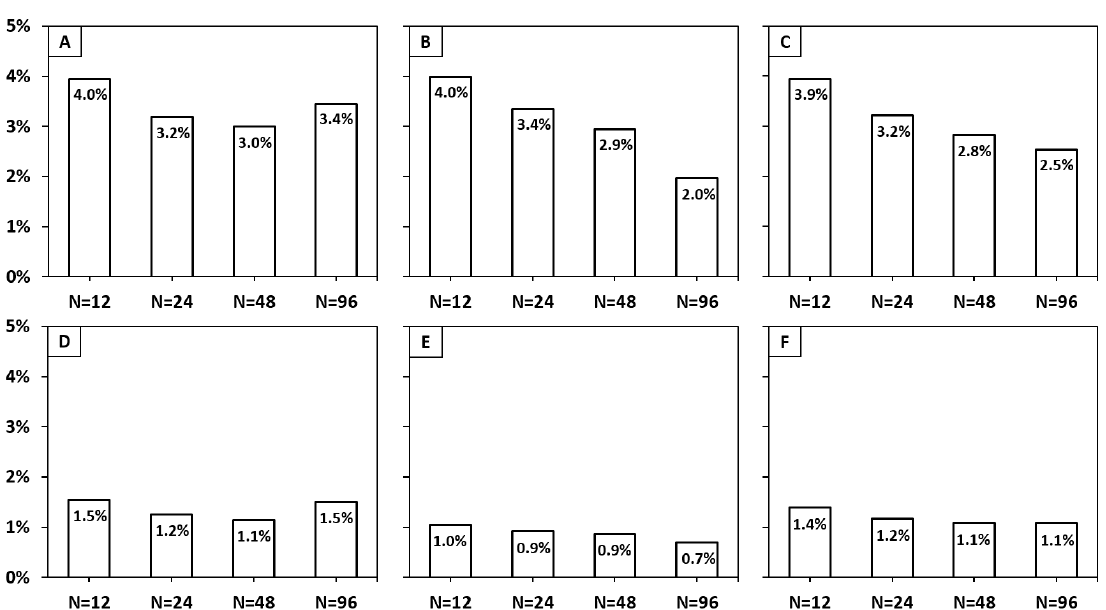
Figure 7. Calculated standard deviations for different sample sizes: ( A ) wood surface of rectangular geometry test series, ( B ) wood surface of round geometry test series, ( C ) wood surface total, ( D ) bark surface of rectangular geometry test series, ( E) bark surface of round geometry test series, ( F ) bark surface total.